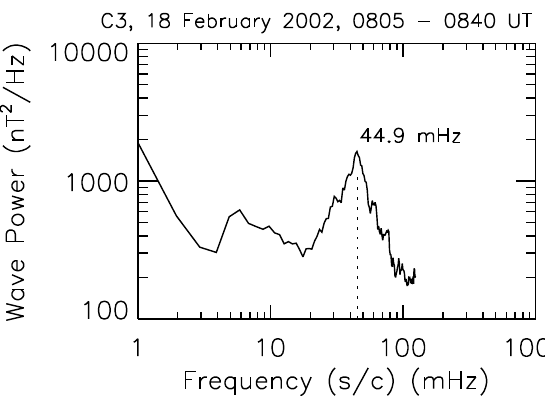
Fig. 3. Power spectrum in frequency domain in the spacecraft frame for the magnetic field data from Cluster 3 for the same interval as Fig. 2.